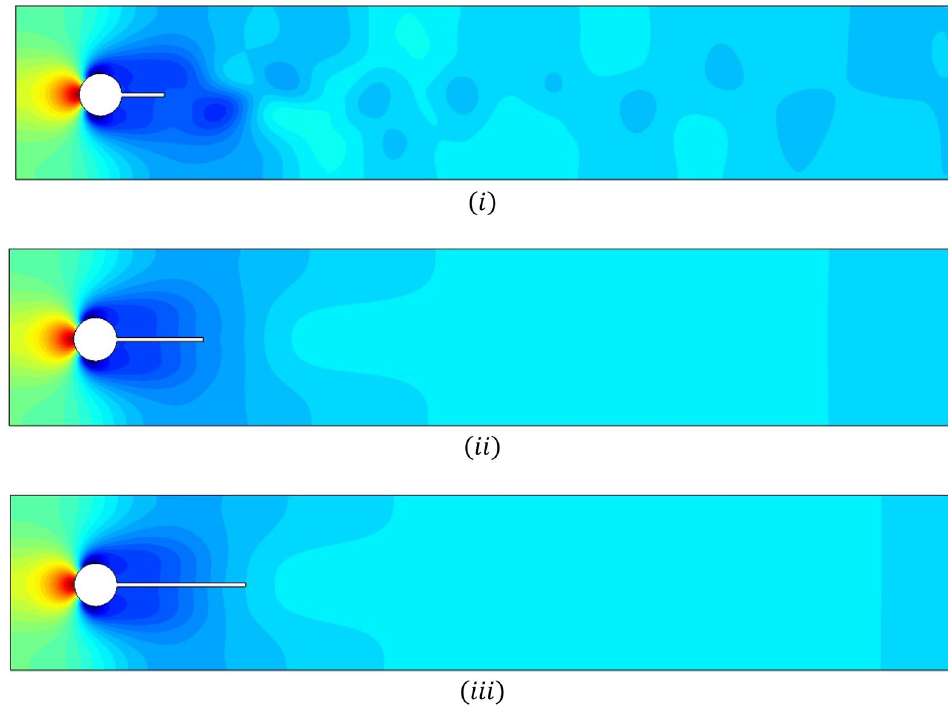
Figure 7. Influence of attached splitter plates on pressure, of lengths ( i ) L 1 = 0.1, ( ii ) L 2 = 0.2, ( iii ) L 3 = 0.3 with Re = 100 at t = 10.